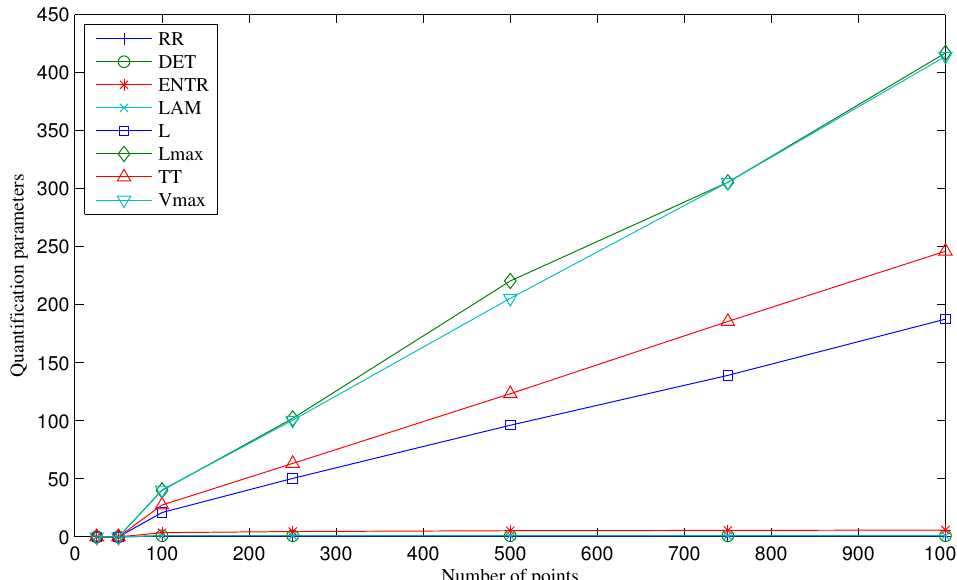
Figure 12. RQA quantification for the smoothed Gaussian peaks with different sample